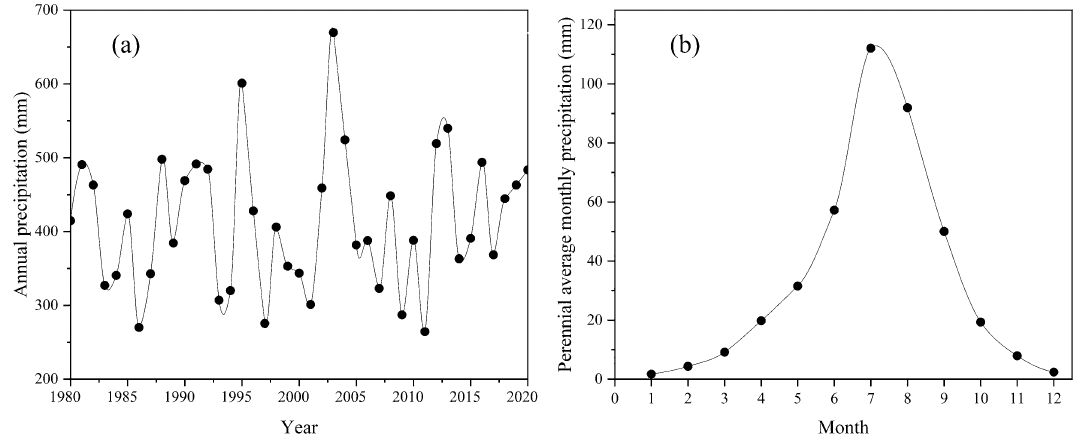
Figure 5. ( a ) Distribution curve of annual precipitation in Daihai Basin; ( b ) Distribution curve of annual mean monthly precipitation in Daihai Basin.